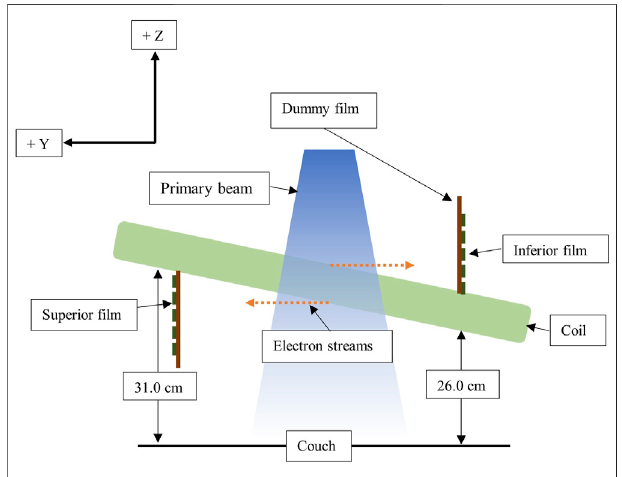
FIGURE 2 | Schematic showing the fi lm setup for coil ESE measurements, not to scale. The IEC61217-positive Y and Z axes are shown.